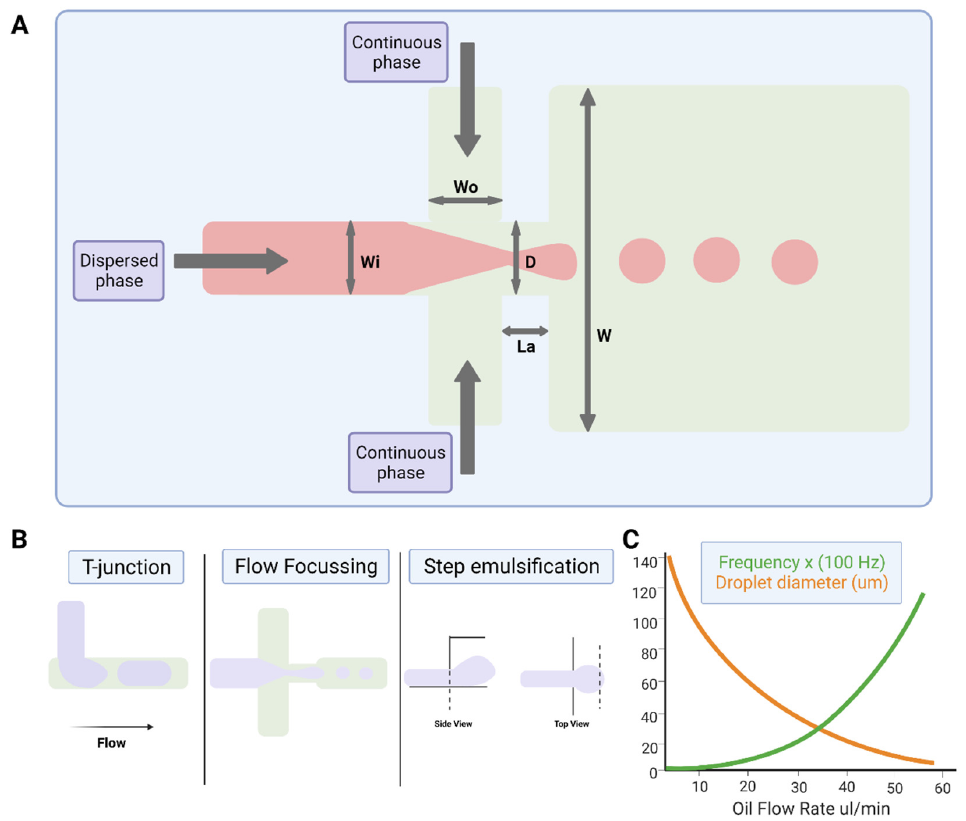
Figure 2. Water-in-oil droplet-generation microfluidics. ( A ) Production of water-in-oil droplets using a flow-focusing design. The dispersed phase is squeezed by two counter-streaming flows of the carrier phase, forcing drops to form and detach. ( B ) Droplet generation using T-junction, flow-focusing geometry and step emulsification. ( C ) Graph showing that droplet size decreases, and frequency of formation increases with increasing oil flow rate. Figures created on Biorender.com, accessed on 9 November 2021.